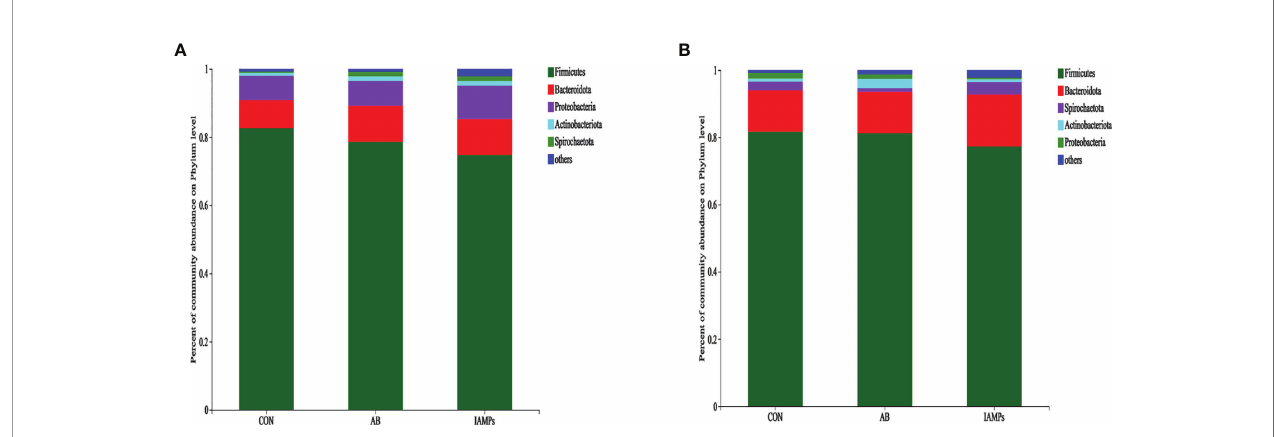
FIGURE 5 | The composition of microbiota at the phylum level in the cecal and colonic digesta samples of weaning piglets. (A) Cecum; (B) colon. The individual pig was regarded as the experimental unit (n = 5). CON, corn – soybean meal-based diet; AB, CON + 25 mg/kg fl avomycin + 50 mg/kg quinocetone; IAMPs, CON + 1,000 mg/kg IAMPs.